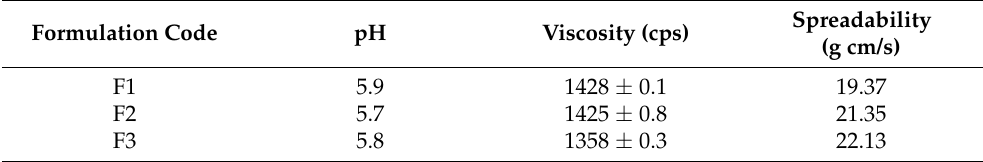
Table 7. Measurement of pH, viscosity, and spreadability.